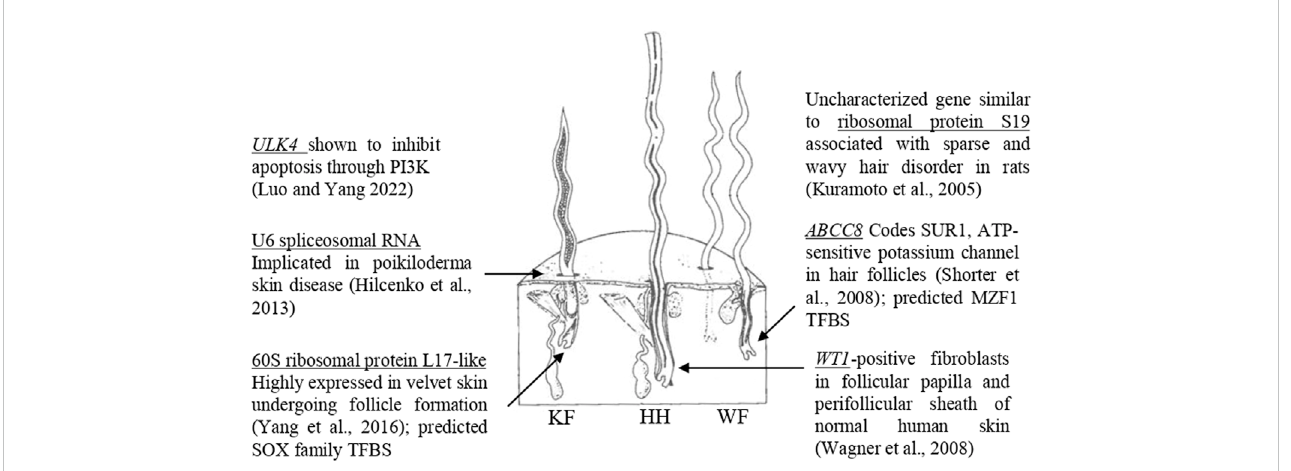
FIGURE 6 Genes with biological functions relevant to follicular growth. Signi fi cant SNPs identi fi ed in GWAS are located within or near genes with known biological roles relevant to skin and follicular growth, including ULK4 (Luo and Yang 2022), U6 spliceosomal RNA (Hilcenko et al., 2013), 60S ribosomal protein L17-like (Yang et al., 2016), ribosomal protein S19 (Kuramoto et al., 2005), ABCC8 (Shorter et al., 2008) and WT1 (Wagner et al., 2008). The signi fi cant SNPs within 60S ribosomal protein L17-like and ABCC8 had predicted TFBS score differences between reference and alternate alleles. The fi gure illustrates the three types of fi bers which comprise sheep ’ s wool, adapted from Bradford and Fitzhugh, 1983. KF, kemp fi ber; HH, heterotype hair; WF, wool fi